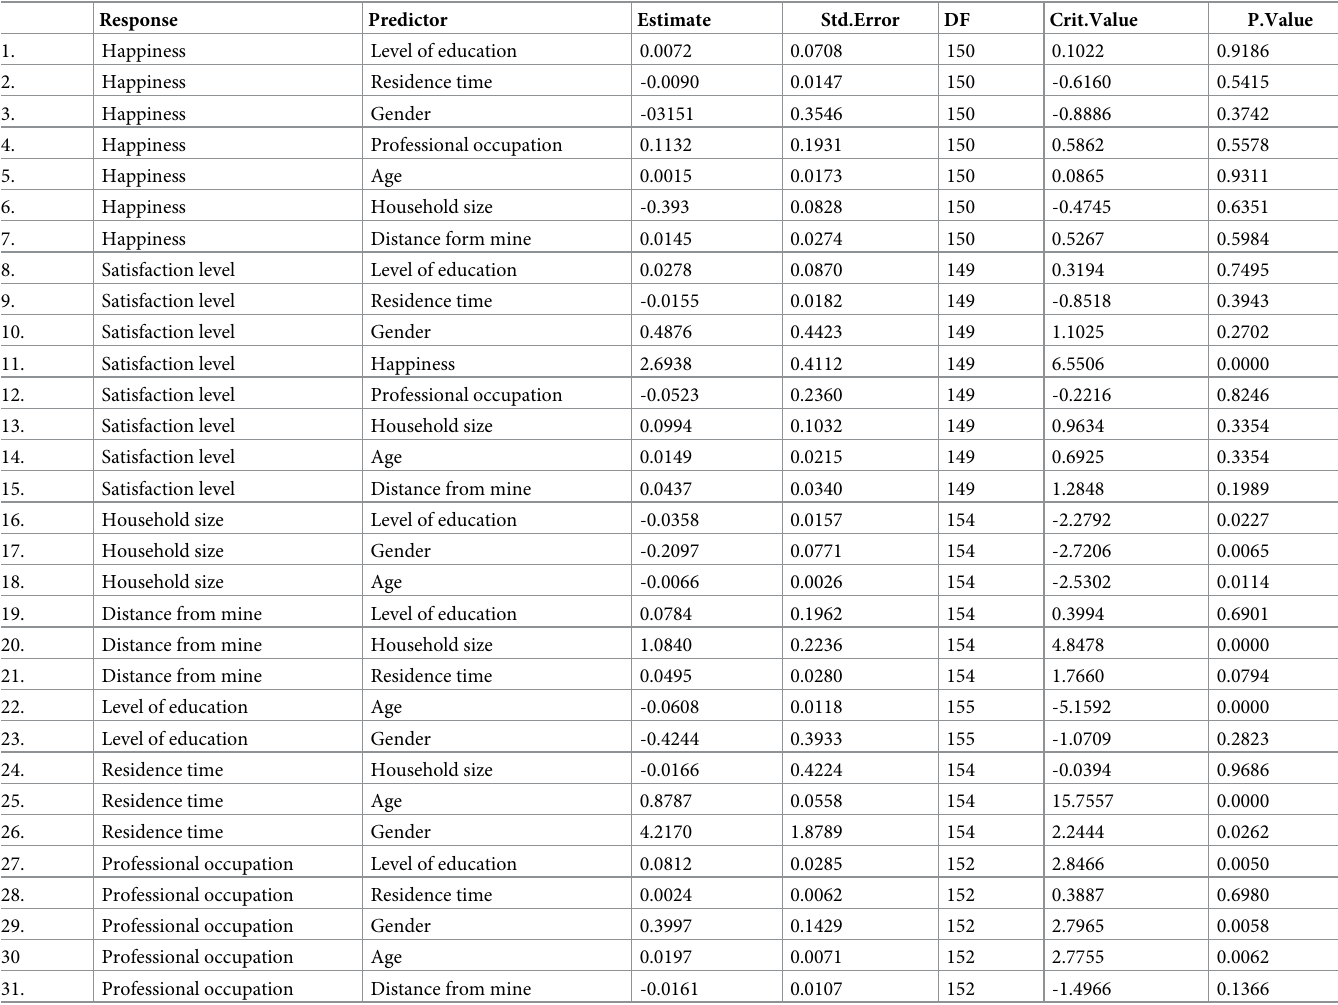
Table 2. Path coefficients of all relationships among variables included in the SEM model for all communities